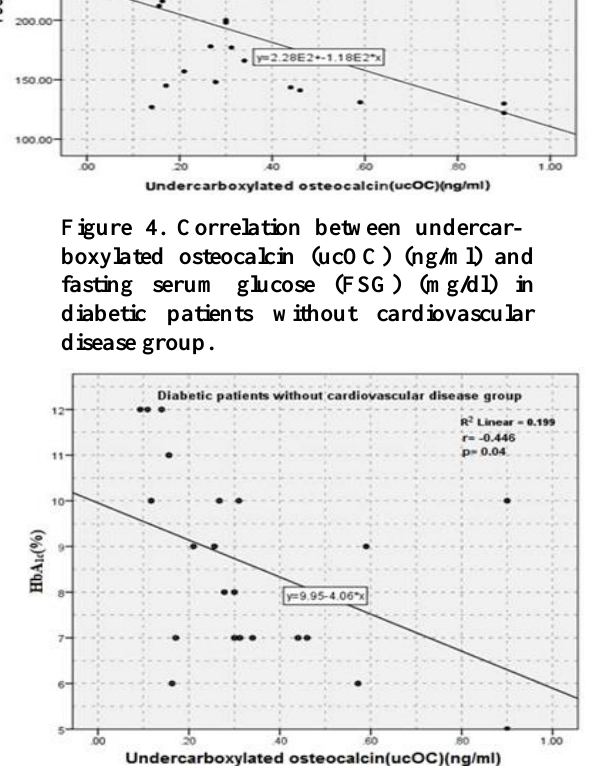
Figure 6. Serum fibroblast growth factor -23 in diabetics and control groups. *=significantly different from control. ∆=significantly different from group